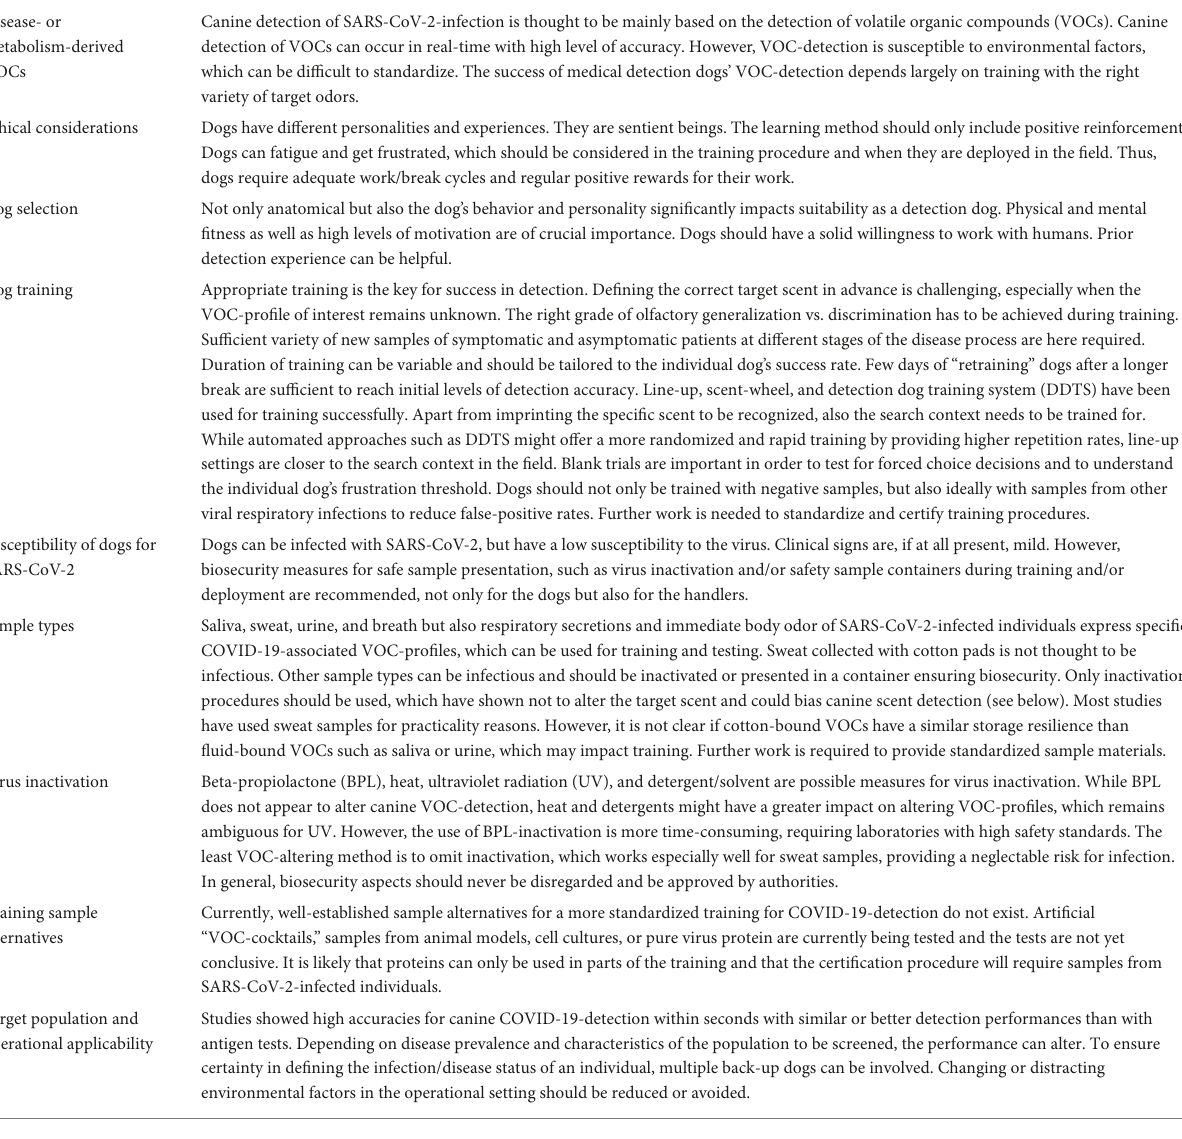
Disease- or metabolism-derived VOCs